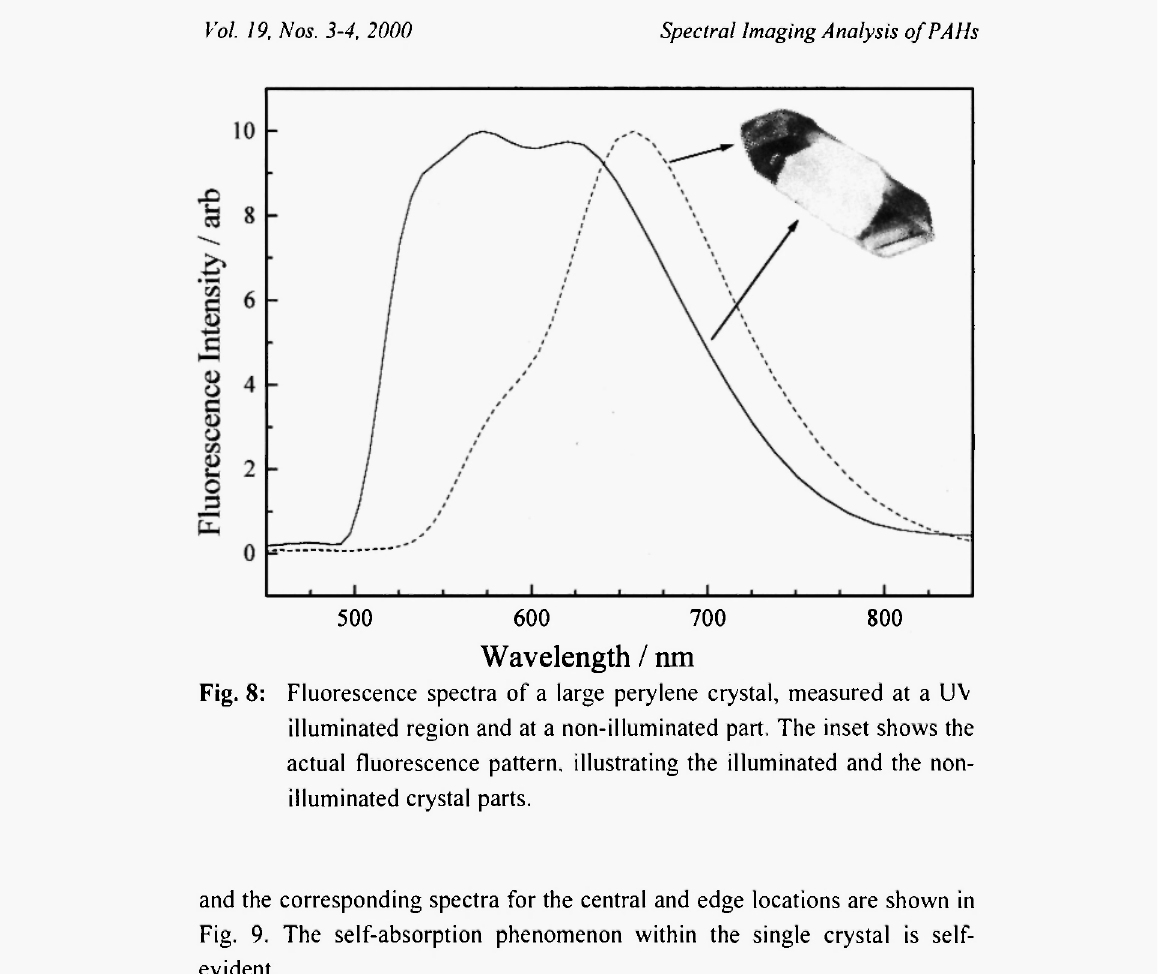
Fig. 8: Fluorescence spectra of a large perylene crystal, measured at a UV illuminated region and at a non-illuminated part. The inset shows the actual fluorescence pattern, illustrating the illuminated and the non- illuminated crystal